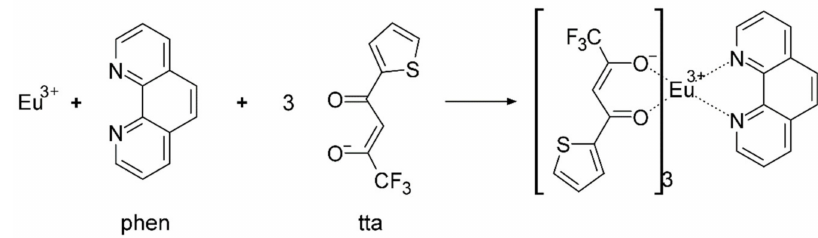
Figure 3. Synthetic procedure for Eu(tta) 3